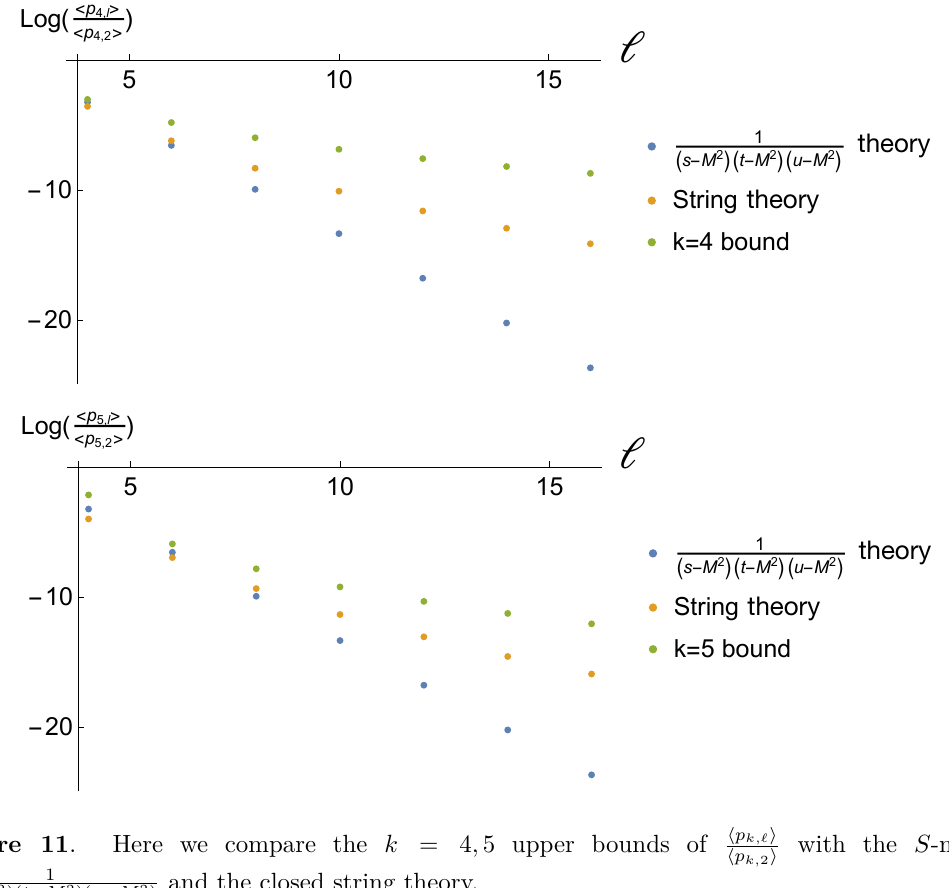
with the S -matrix h p k, 2 i